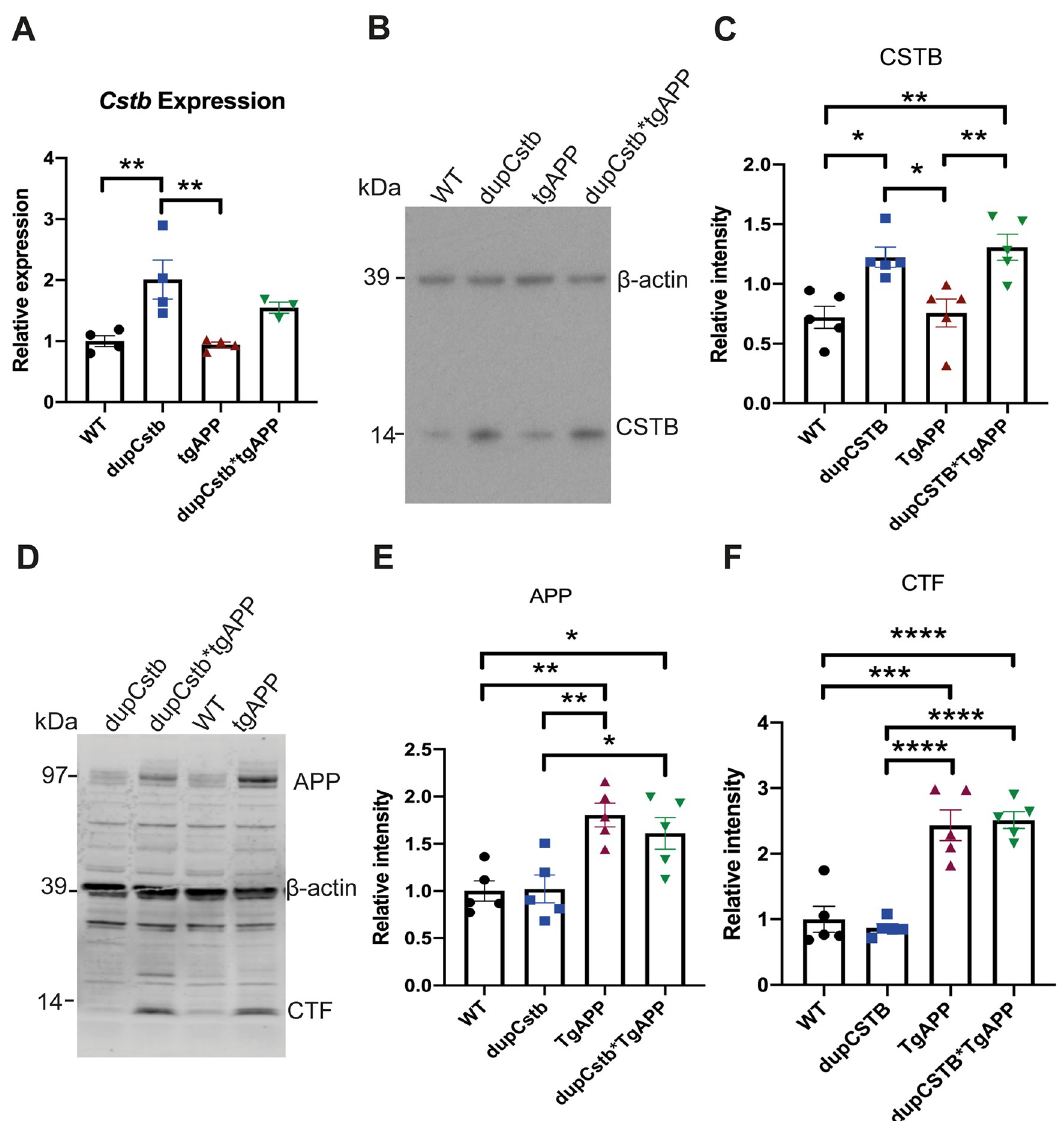
Fig 1. Transcriptional and translational levels of cortical CSTB in 3-month-old mice. (A) Levels of Cstb mRNA in the cortex of 3-month old mice. Data are relative to Actb and Gapdh housekeeping genes, and represented as mean expression levels for mice of each genotype ± SEM. Duplication of Cstb caused an increase in the relative levels of Cstb mRNA (F(1,7) = 7.240, p = 0.031). No effect of sex, tgAPP, or interaction between dupCstb and tgAPP was evident (n = 3–5 per genotype, 9 females and 9 males in total). (B) Representative western blot probed with anti-CSTB and anti- β -actin antibodies. (C) Protein band density was quantified using ImageJ, normalised to β -actin, and is shown as fold-change relative to wildtype levels (mean ± SEM), n = 5 for each genotype (9 females and 11 males in total). (D) Representative western blot probed with anti-APP C-Terminal Fragment (CTF) and anti- β -actin antibodies. (E) APP protein band density was quantified using ImageJ, normalised to β -actin, and is shown as fold-change relative to wildtype levels (mean ± SEM), n = 5 for each genotype (9 females and 11 males in total). (F) CTF protein band density was quantified using ImageJ, normalised to β -actin, and is shown as fold-change relative to wildtype levels (mean ± SEM), n = 5 for each genotype (9 females and 11 males in total). Bonferroni post-hoc pair-wise comparisons p < 0.05 = � , p < 0.01 = �� , p < .001 = ��� , p < 0.0001 = ����